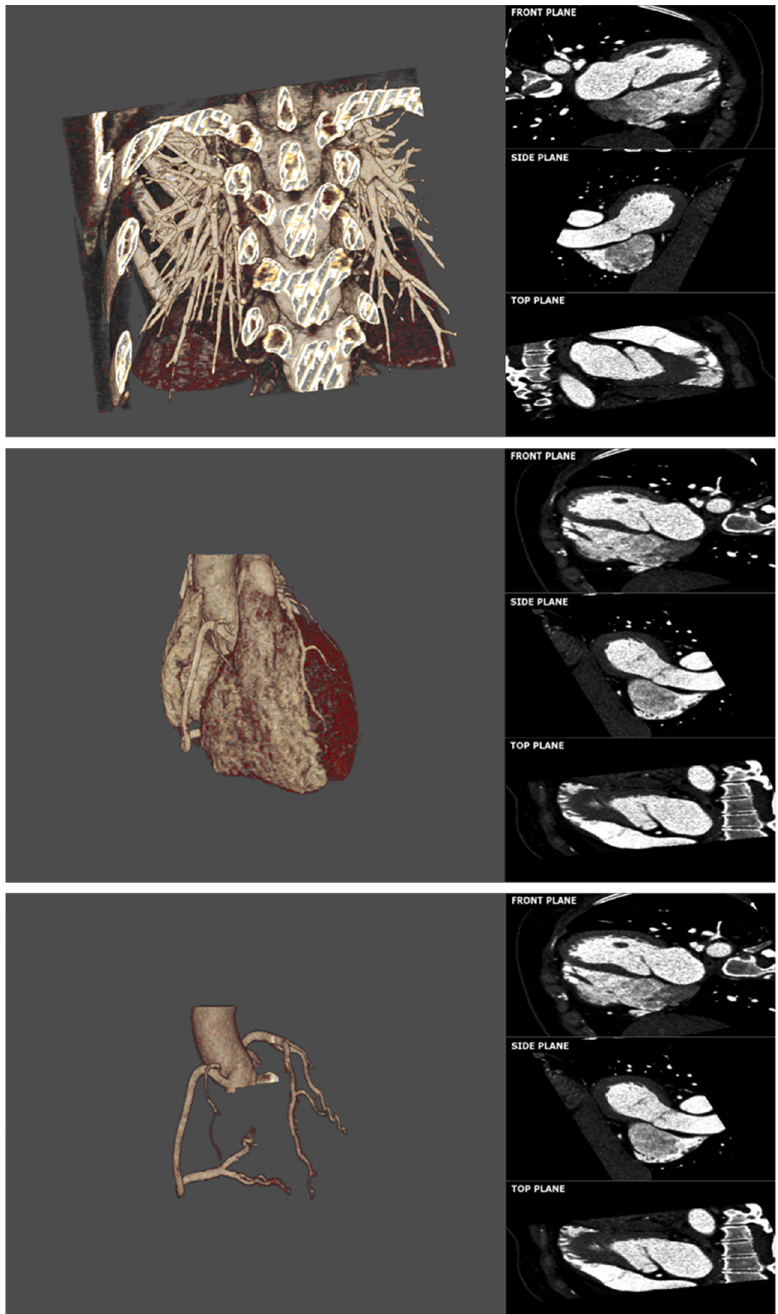
Figure 7. Three-dimensional cardiac CT navigator software prototype. The images show the volume rendered original CT images without any pre-processing (1st row), a segmented whole heart (2nd row), and segmented coronary arteries (3rd row).